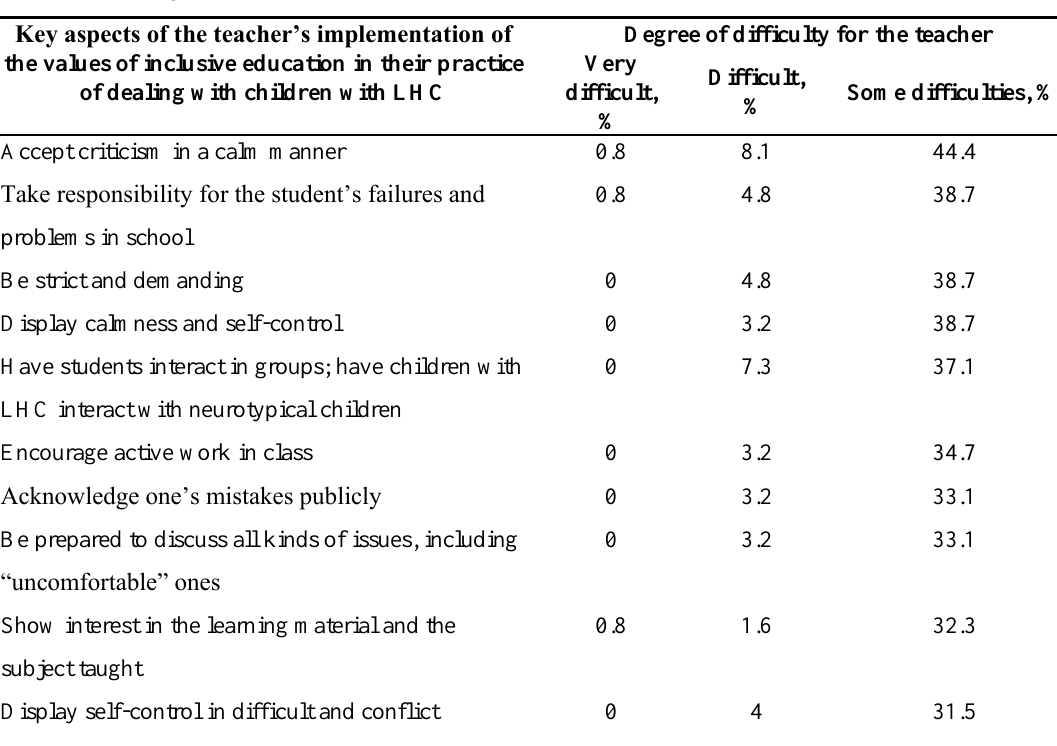
Table 5. Difficulties Faced by Teachers in Implementing the Values of Inclusive Education in Their Practice of Dealing with Children with